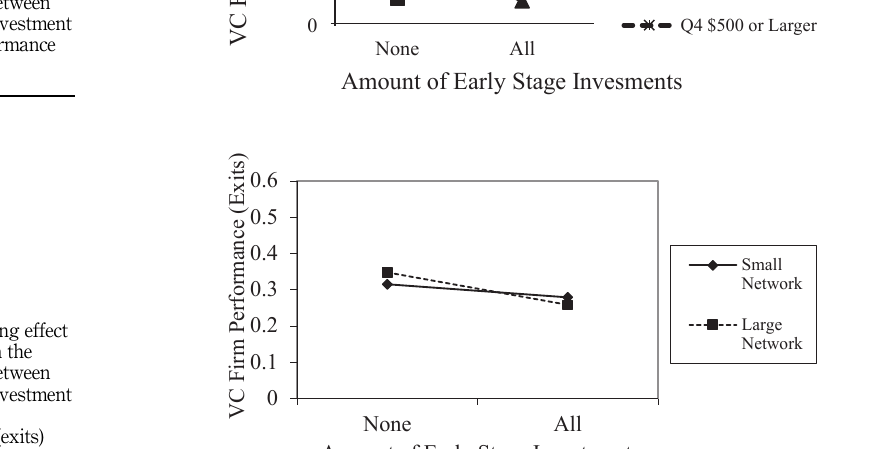
Figure 2. The moderating effect of size on the association between early stage investment and VC performance